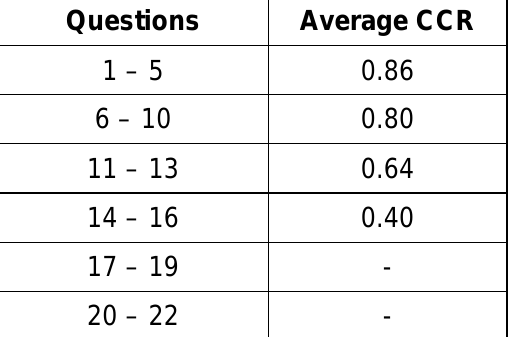
Table 3. Average CCR per question type.